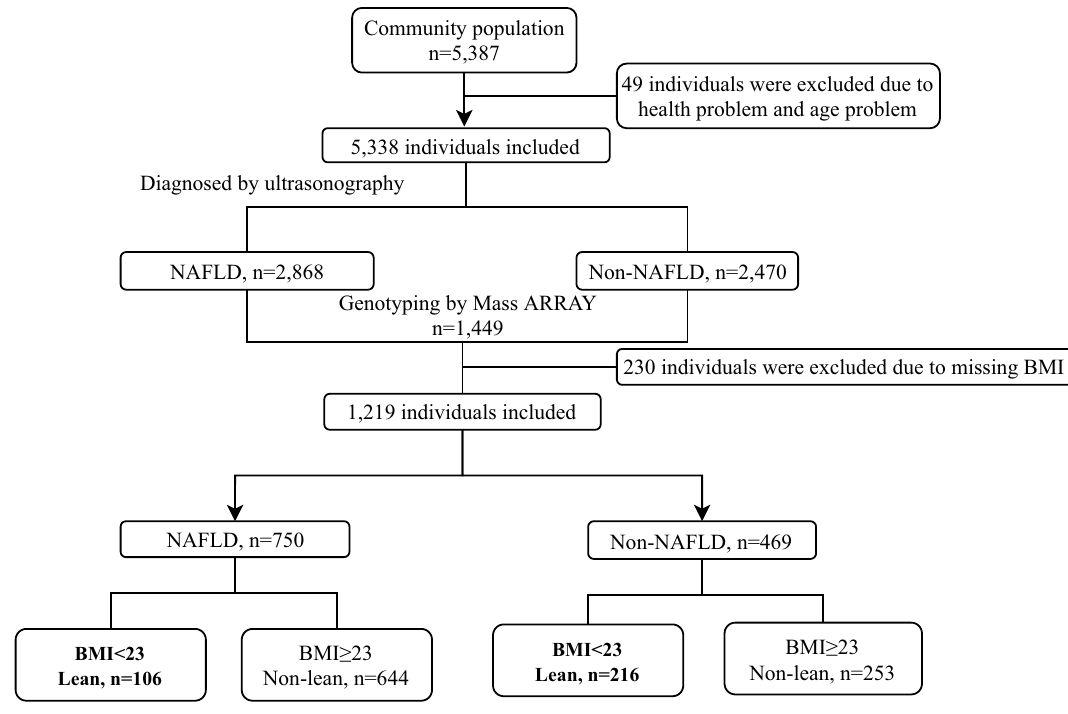
Figure 1. Study flowchart. BMI Body mass index, NAFLD non-alcoholic fatty liver